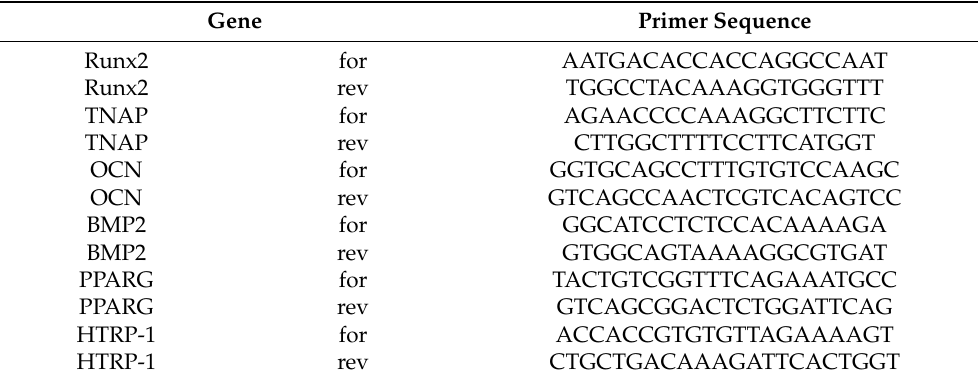
Table 2. qRT-PCR Primer